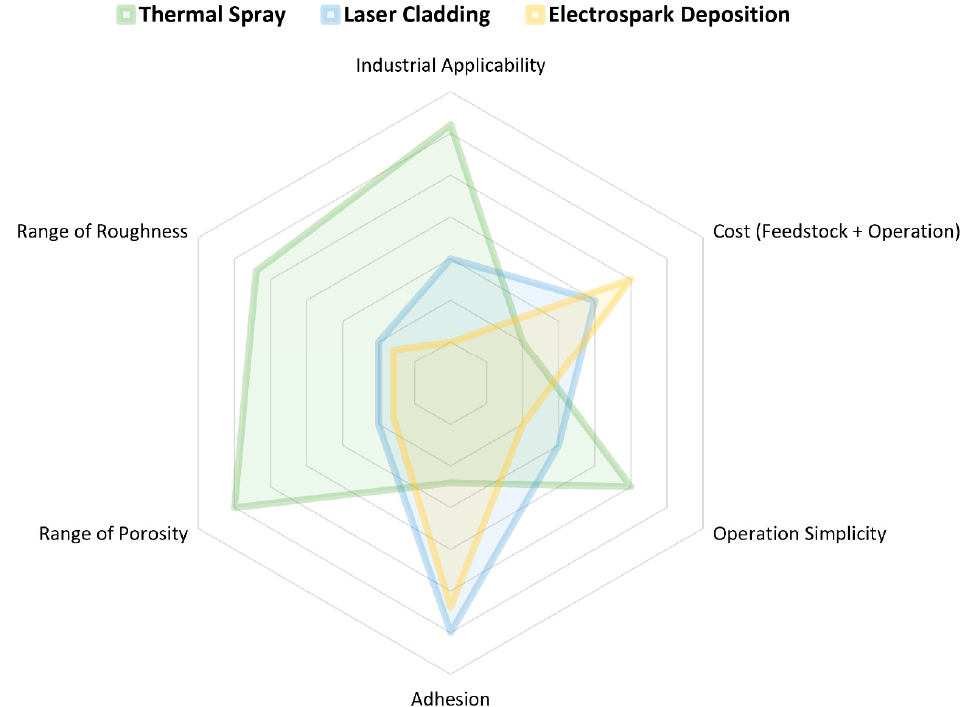
Figure 9. Comparison of the commonly used techniques for the deposition of MCrAlY-based coatings.